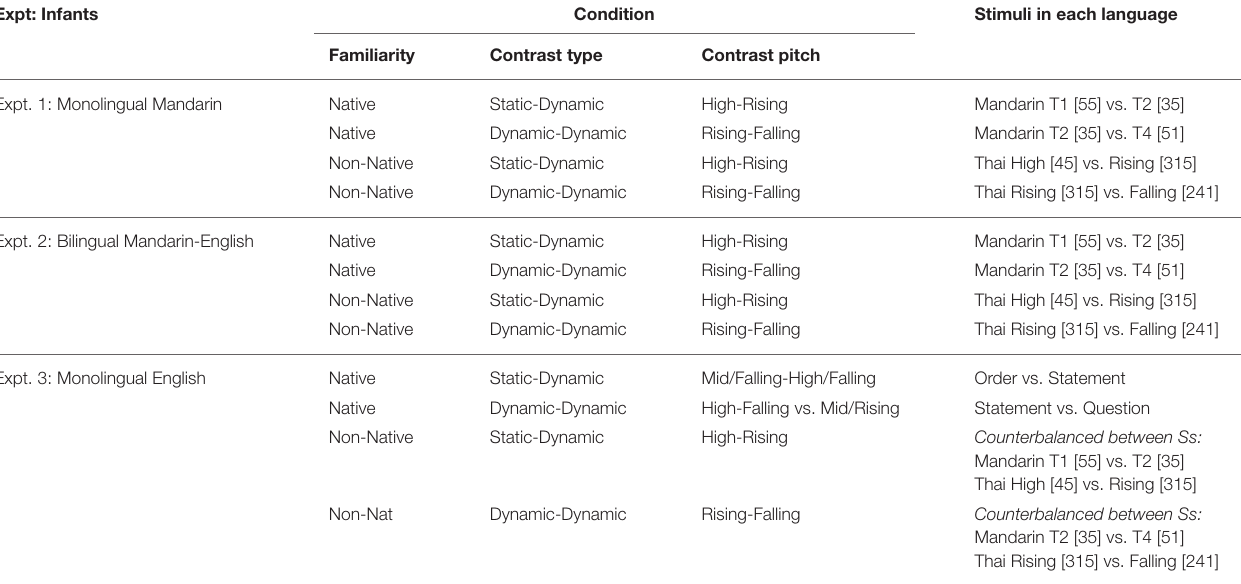
TABLE 1 | Language and Tone Contrast Familiarity and Tone Contrast Properties used in the four conditions of the habituation then switch task in Experiments 1, 2, and 3. Expt: